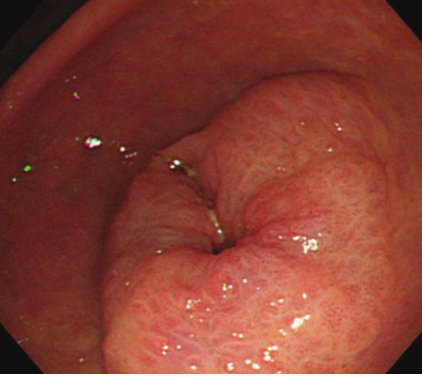
Figure 1: Upper gastrointestinal endoscopy revealed a circumferential tumor located at the antrum of the stomach.